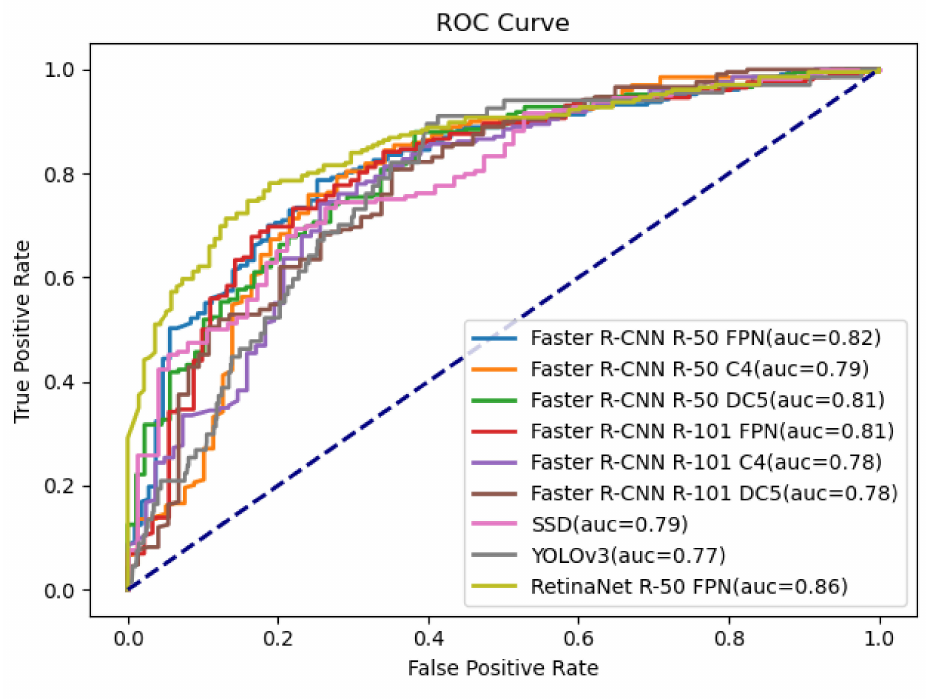
Figure 14. Receiver operating characteristics (ROC) curve for all the models.